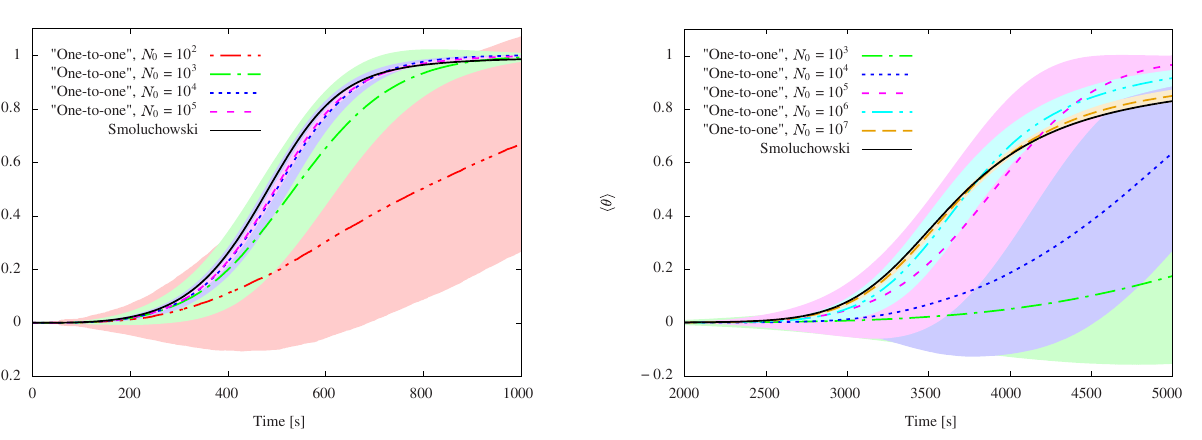
Figure 8. As in Fig. 7 but for an initial distribution with r = 9.3µm, n 0 = 297cm − 3 and a cutoff at r = 20µm. The ensemble size is (cid:127) = 10 8 /N 0